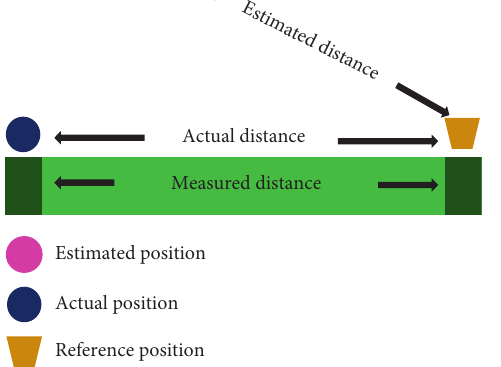
Figure 8: Distance between sensor